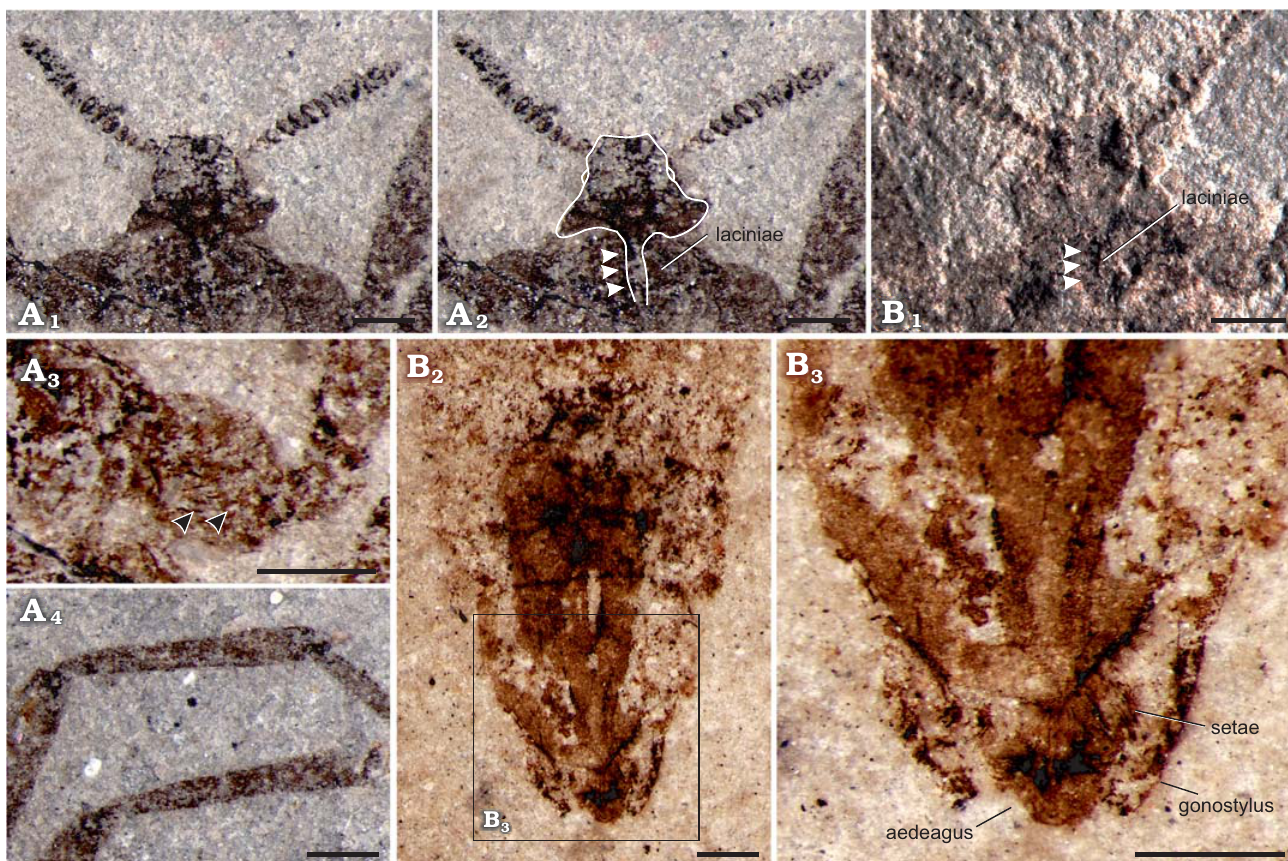
Fig. 2. Saurophthirid flea Saurophthirus laevigatus Zhang, Shih, Rasnitsyn, and Gao sp. nov., male (holotype, CNU-SIP-LL2015001) from the Lower Cretaceous Yixian Formation of Northeastern China. A . Part, head in ventral view (A 1 ), head with position of the mouthpart indicated (A 2 , white arrow- heads referring laciniae), bristles of the coxae (A 3 , black arrowheads referring bristles), tibia of the fore leg (A 4 ). B . Counterpart, the laciniae under the unilateral light (B 1 ), terminalia of the abdomen showing the setae (B 2, B 3 ). A 3 , B 2 , B 3 , photographed under alcohol. Scale bars 0.5